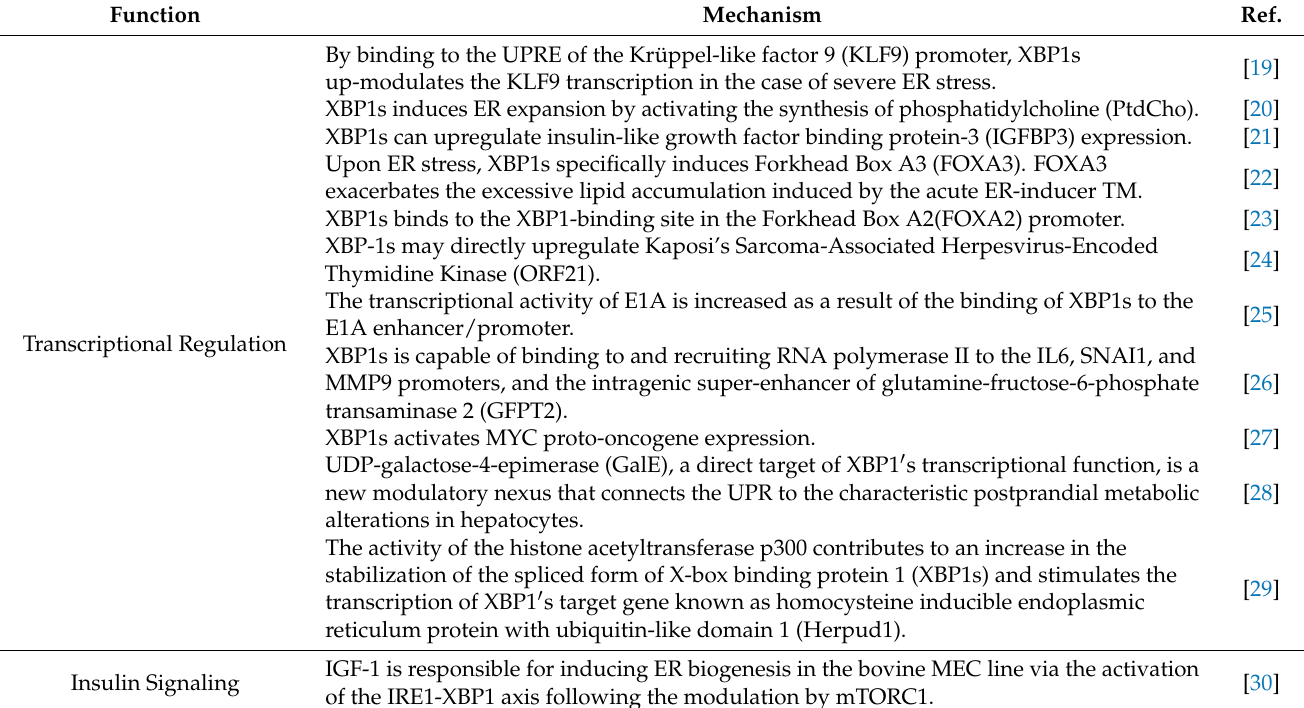
Table 1. Cellular functions of XBP1s and related mechanism of